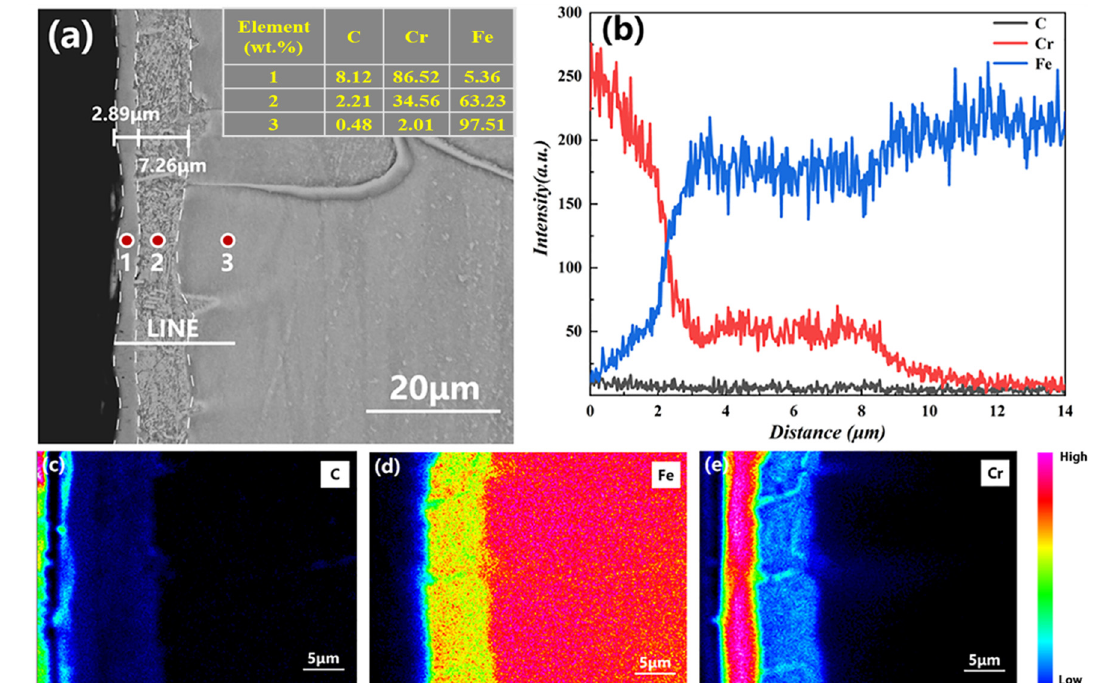
Figure 5. ( a ) Cross-sectional morphology of the chromized SPCC steel. ( b ) Elemental distribution trend along the straight line shown in ( a ); surface scanning of ( c ) C, ( d ) Fe, and ( e ) Cr distributions.